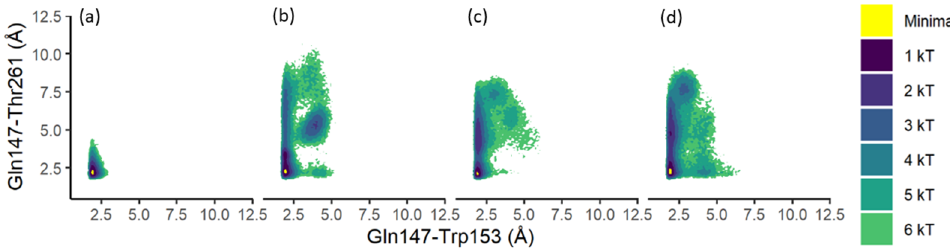
Figure 2. ΔG distribution of the paired Gln-Trp and Gln-Thr distances. ( a ) Substrate; ( b ) Product; ( c ) Apoprotein models; ( d ) CoA models. Values less than 0.1 kT shown in yellow represent minima. For the combined Substrate model simulations, the ΔG minimum appeared at Gln147-Trp153 = 2.0 Å and Gln147-Thr261 = 2.2 Å and included 3.6% of total observations, whereas